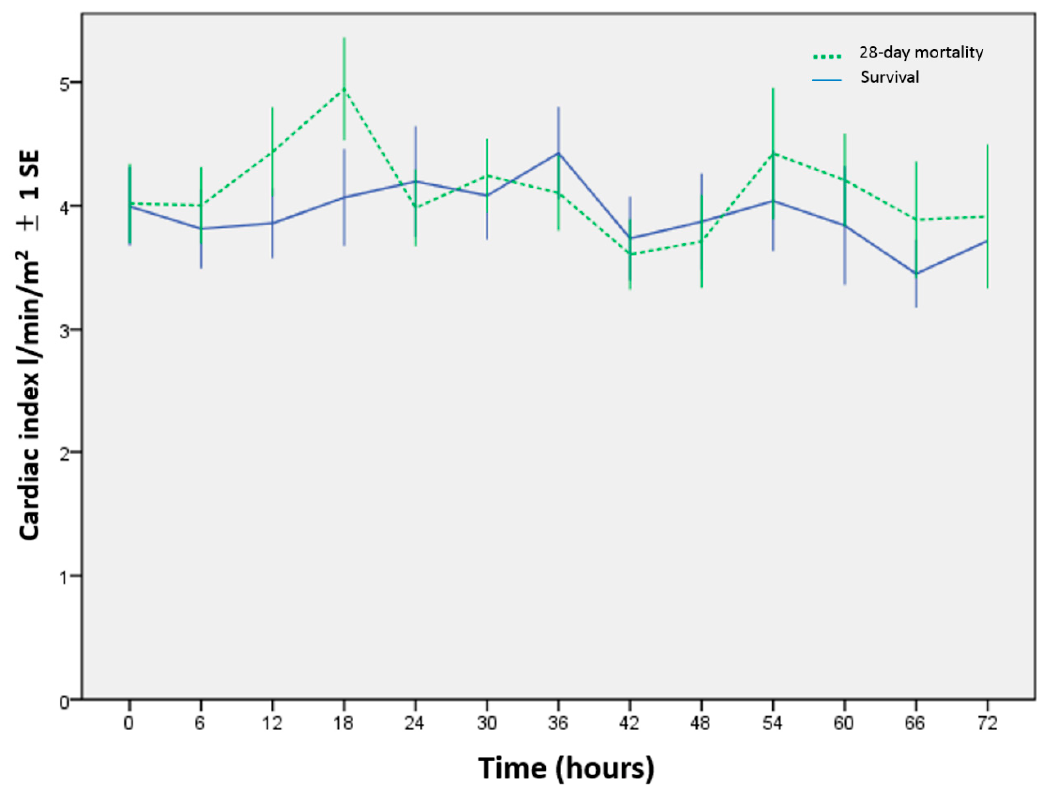
Figure 2. Serial cardiac index (CI) and its variance (mean ± 1 SE bar) after comparing survivors with non-survivors, measured at 6 h intervals. Table 2. Multivariable analysis for the predictors of the 28-day mortality during the first 72 h after admission to the PICU.